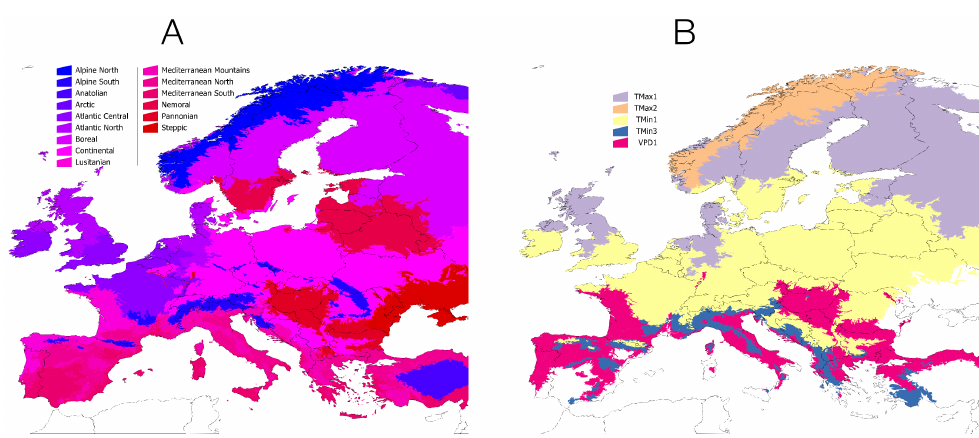
Figure 3. The tick Ixodes ricinus has geographically dependent different responses to environmental features. In ( A ), the climate regions of Europe are included with its standard denomination. A total of 11,349 records of the tick was used to develop an environmental suitability model (described in [31,32]). In the case of the illustration in ( B ), we aimed to pinpoint the most limiting variable for tick presence/absence. We did choose as explanatory variables the three first coefficients of a harmonic regression, obtained as explained in [31–33]. TMAX, TMIN and VPD refer to maximum temperature, minimum temperature, and vapour pressured deficit, respectively. The numbers next to each variable (1, 2, 3) refer to the annual average (1), the index describing the beginning of the spring (2), or the beginning of autumn (3) from the harmonic regression. See [33–35] for complete explanation of the methods that are not the focus of this